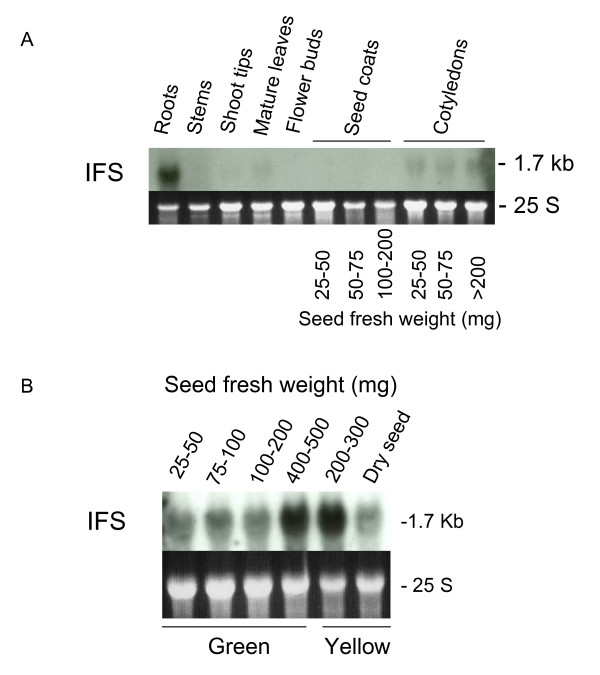
Isoflavone synthase (IFS) tissue-specific expression in Glycine max, cultivar Williams. (A) IFS transcripts (1.7 kb) detected in a RNA blot containing 10 μg of total RNA samples purified from roots, stems, shoot tips, mature leaves, flower buds, seed coats and cotyledons of soybean plants, cv. Williams 82. Seed coats and cotyledons from three different stages of seed development were used. Seed fresh weight in milligrams is shown at bottom. (B) Expression of IFS in the cotyledon of Glycine max, cv. Williams through seed development. The 25 S ribosomal RNAs from the ethidium bromide-stained gel prior to membrane transfer are shown in the dark background sub-panels to compare RNA sample loading. The Gm-c1059-264 soybean cDNA clone was used as probe.